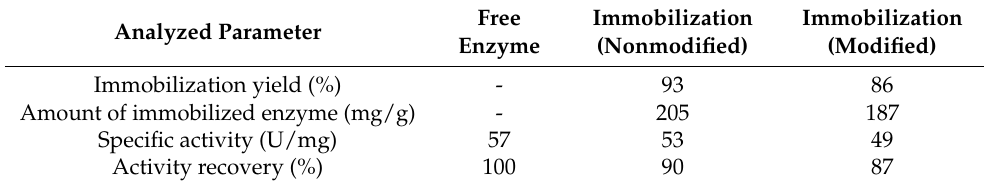
Table 1. Enzyme characteristic before and after immobilization process.